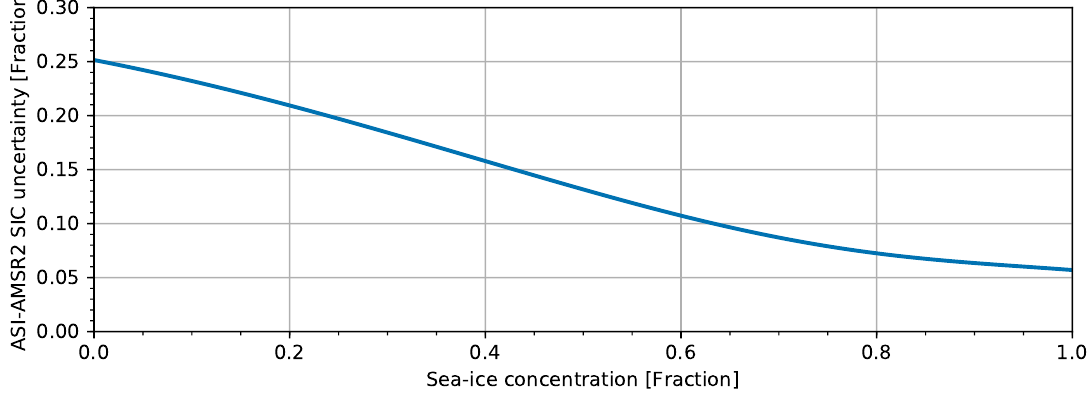
Figure 2. Uncertainty of the AMSR2 SIC as derived in